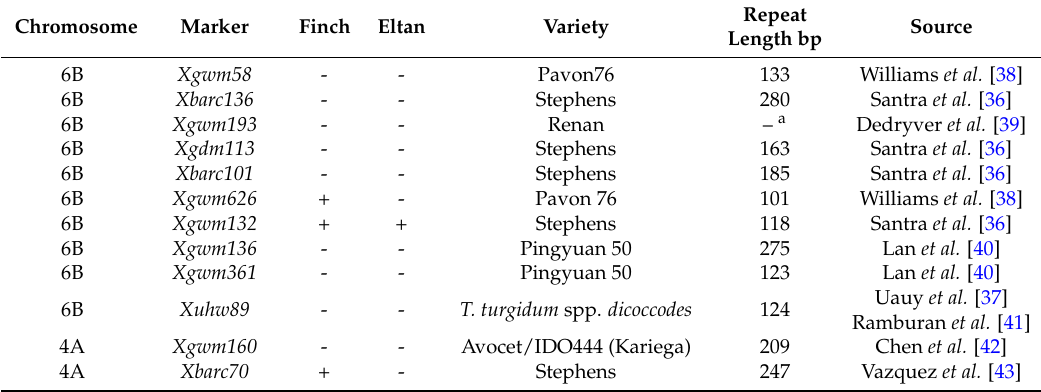
Table 3. SSR markers for varieties with a known 4A or 6B stripe rust quantitative trait loci (QTL) assayed on Finch and Eltan to determine if either had the positive (+) allele length for that varieties resistant QTL.